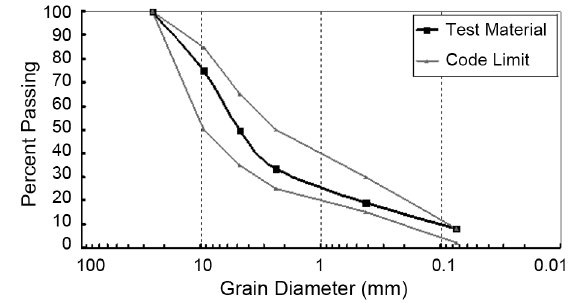
Fig. 6. Grain size distribution curve of the material and its code